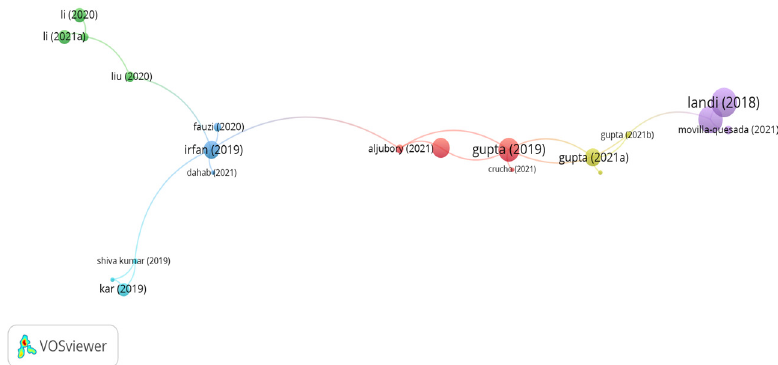
Figure 11. Network visualization of cellulose